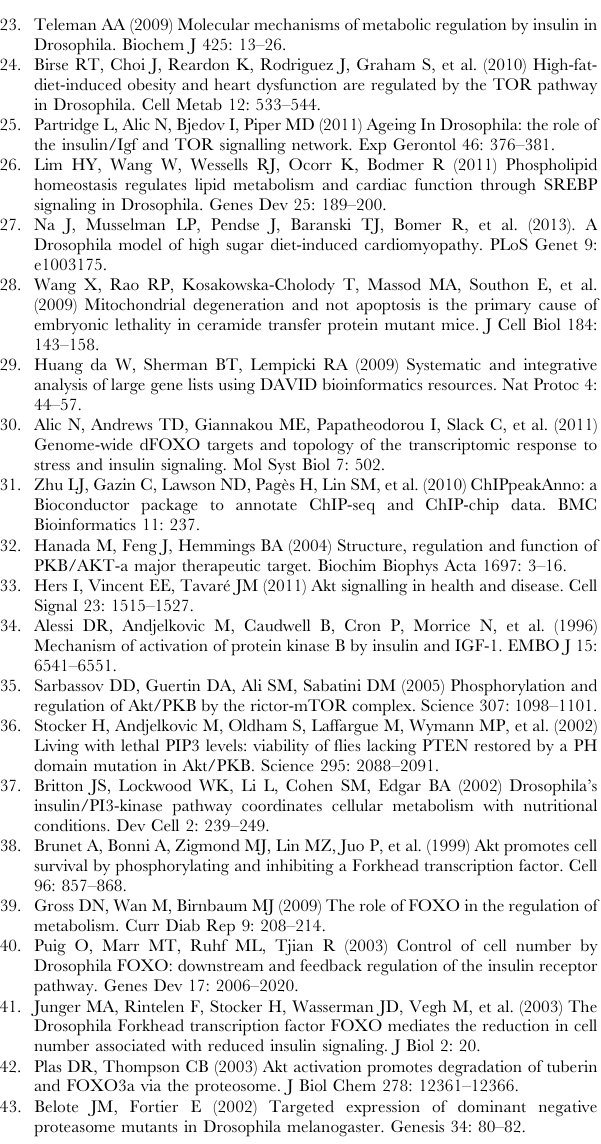
ATP, free fatty acid and glycerol, QPCR analysis, immunofluo- rescence microscopy, activity measurements for glycolytic en- zymes, assays for mitochondrial oxidative phosphorylation com- plexes and feeding of Pseudomonas entomophila